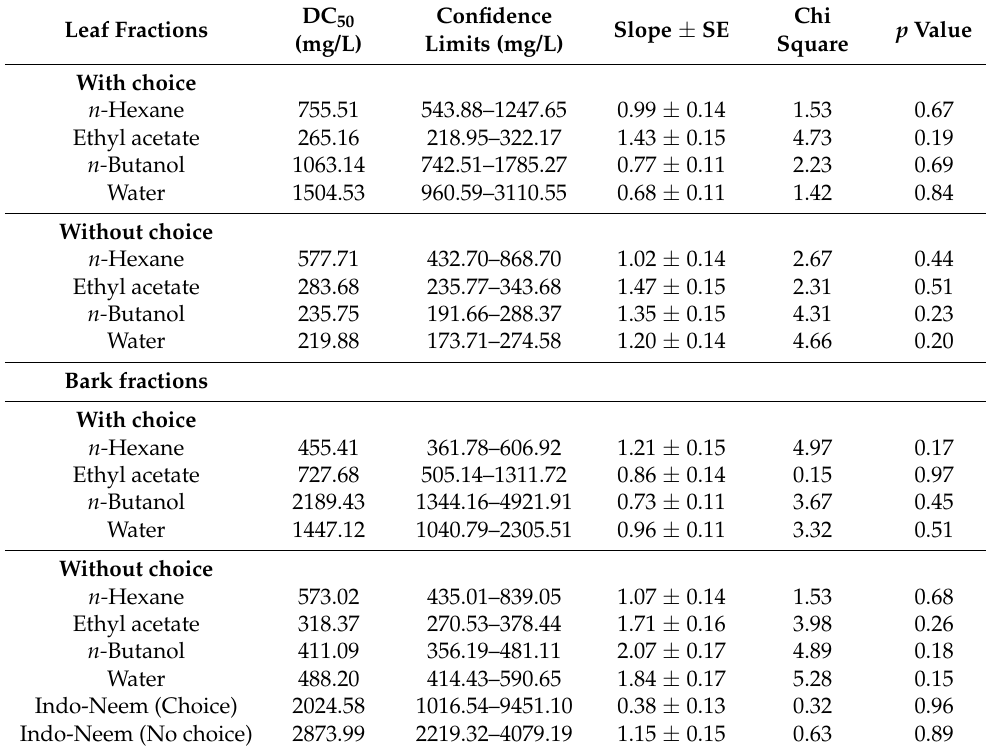
Table 3. Feeding deterrence of leaf and bark fractions of Triadica sebifera against Plutella xylostella . Leaf